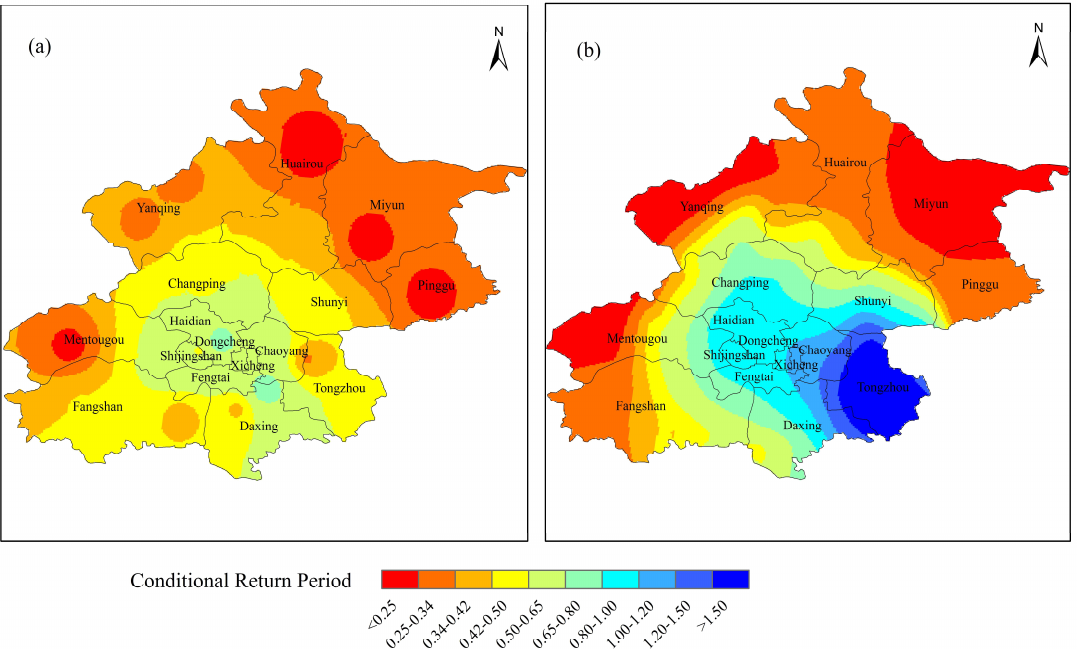
Figure 6. Spatial distributions of conditional return periods for low temperature events with a given intensity threshold of below −12 °C and above −15 °C for study periods: ( a ) 1978–1998; ( b ) 1999–2015 (unit: year).